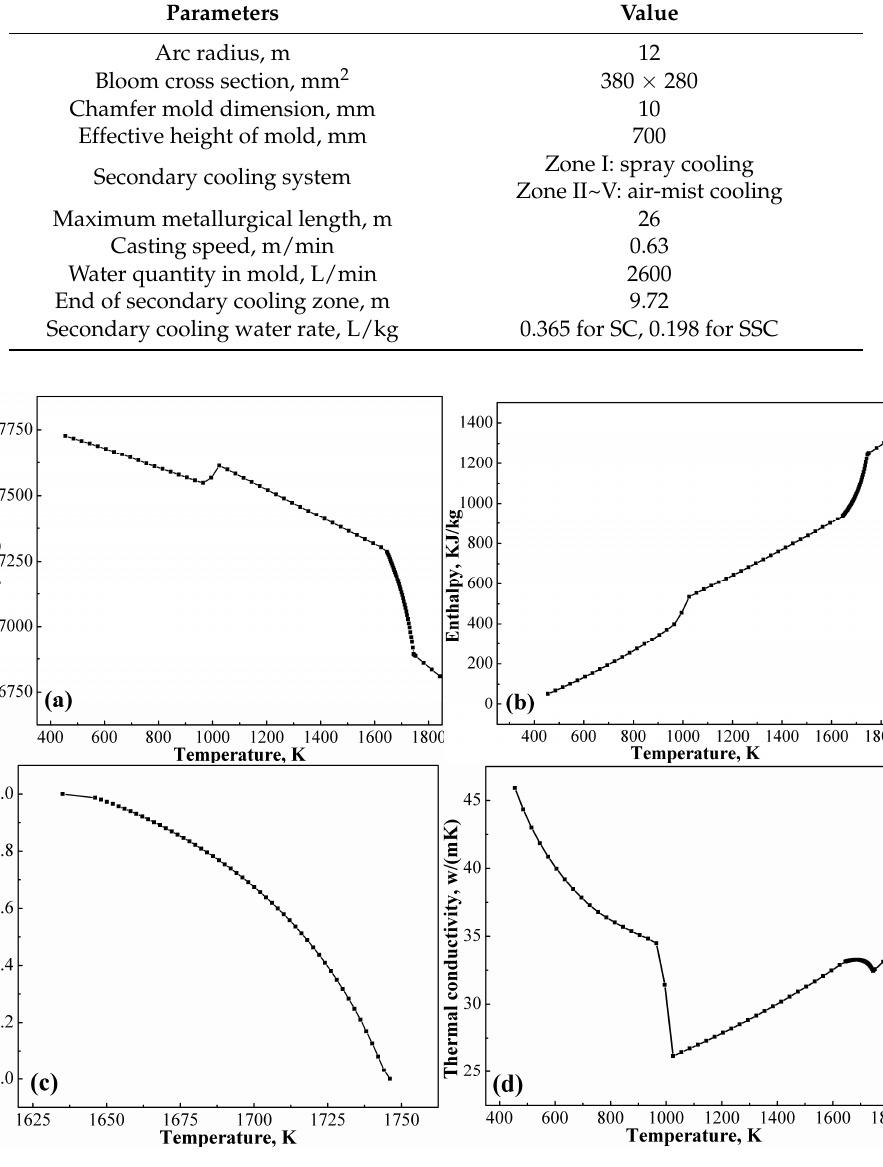
Table 1. Parameters of the bloom caster ( SC: Slow cooling ; SSC: Super-slow cooling).